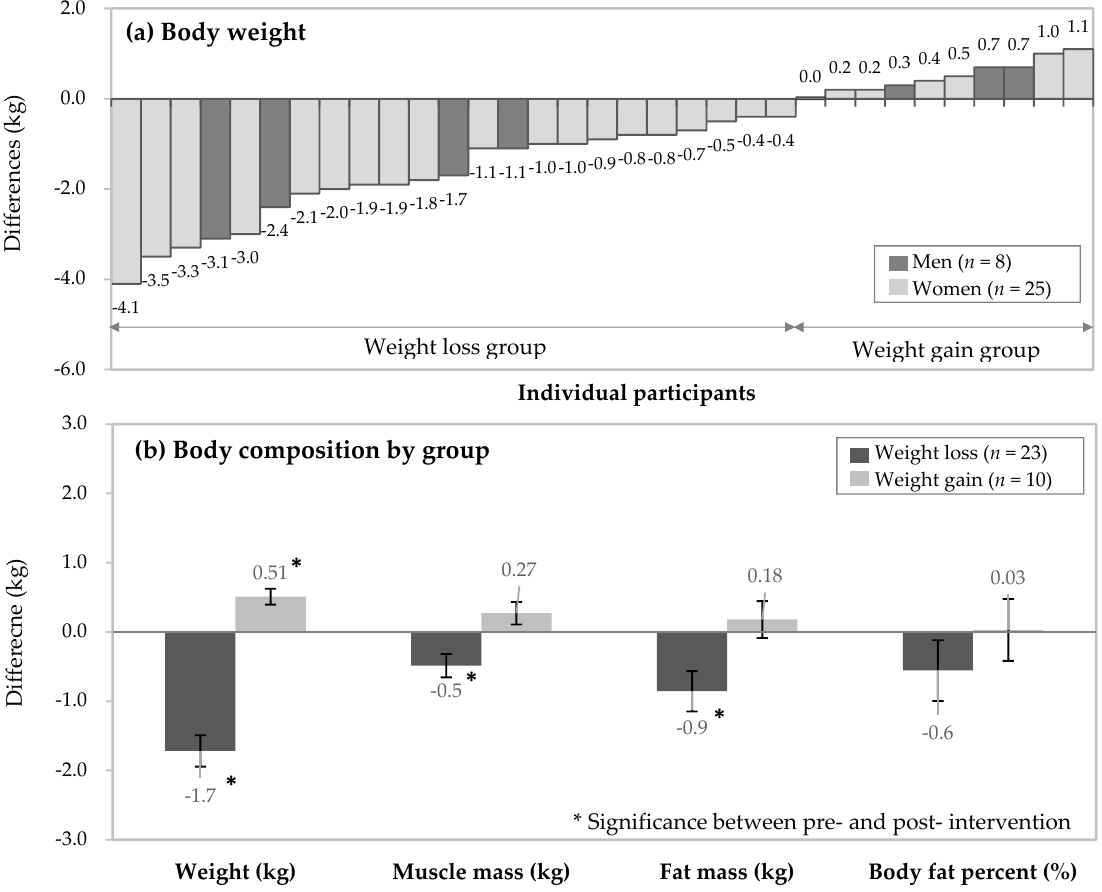
Figure 2. Changes in body composition measures after 4 weeks of time-restricted eating. ( a ) Weight change of each participant; ( b ) average weight change per